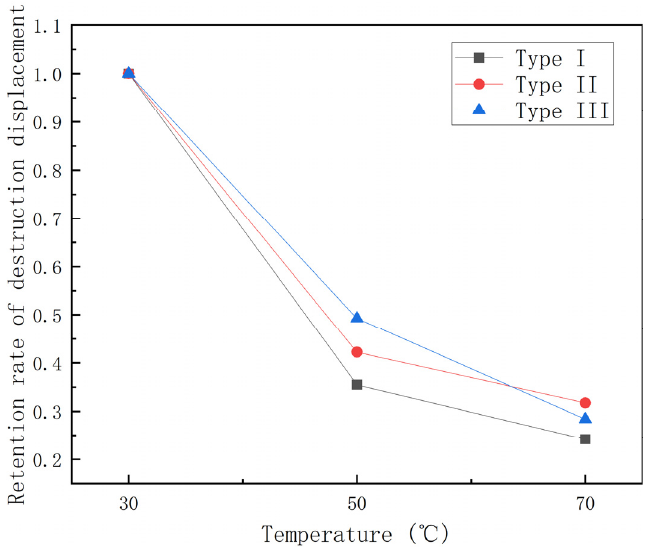
Figure 11. Destruction displacement retention–temperature curve.